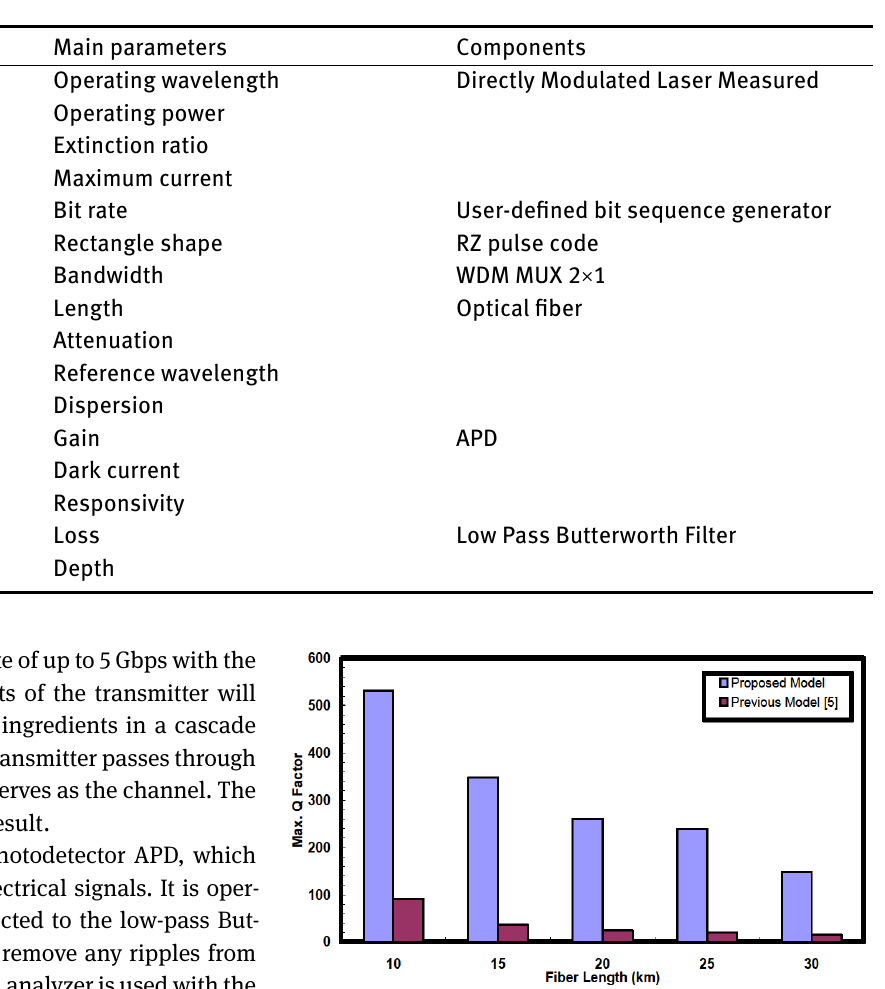
Table 1: List of operating simulation parameters for this study.